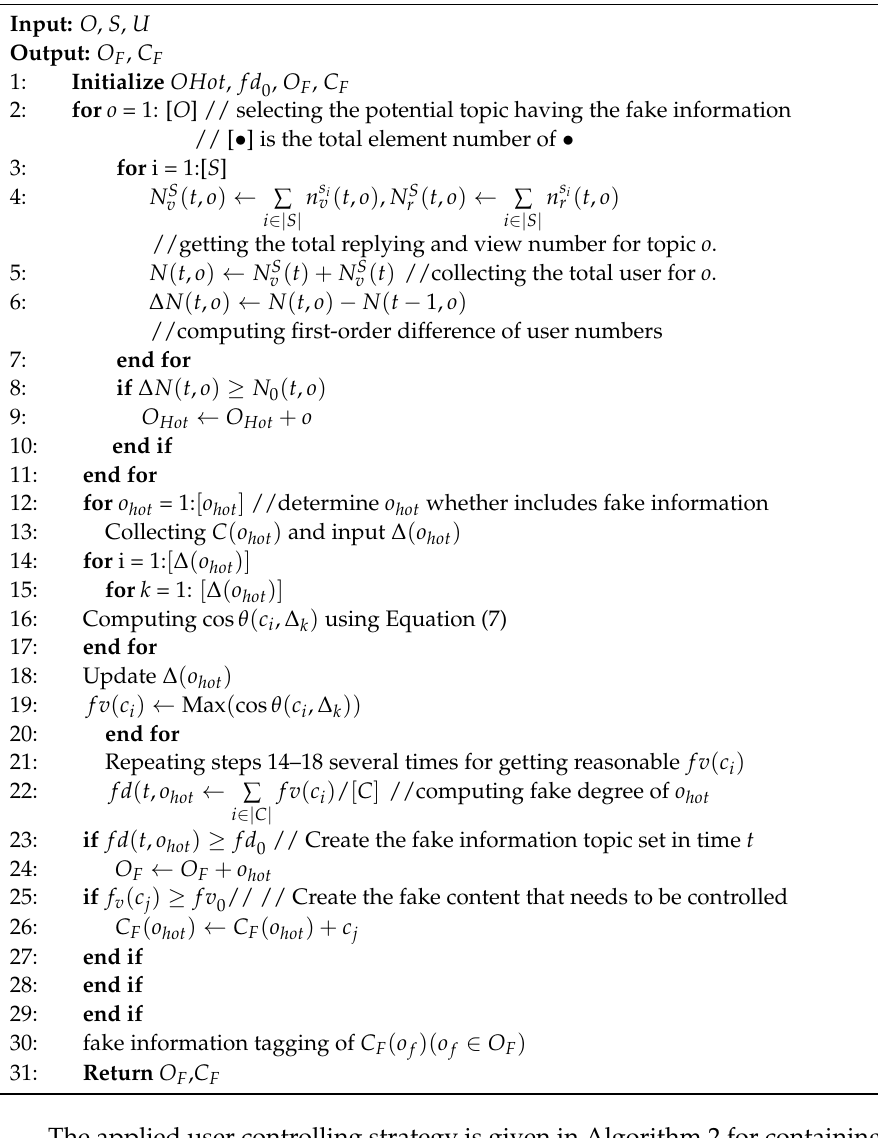
Algorithm 1. Potential fake information selection and fake content